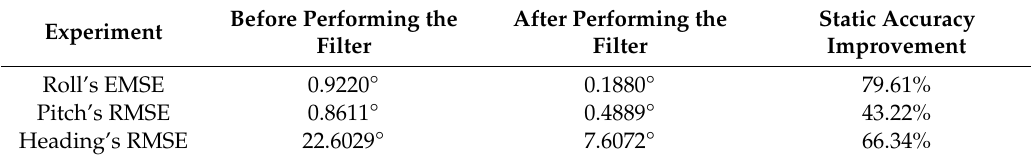
Table 6. Root mean square error (RMSE) of roll, pitch, and heading before and after proposed filter in dynamic